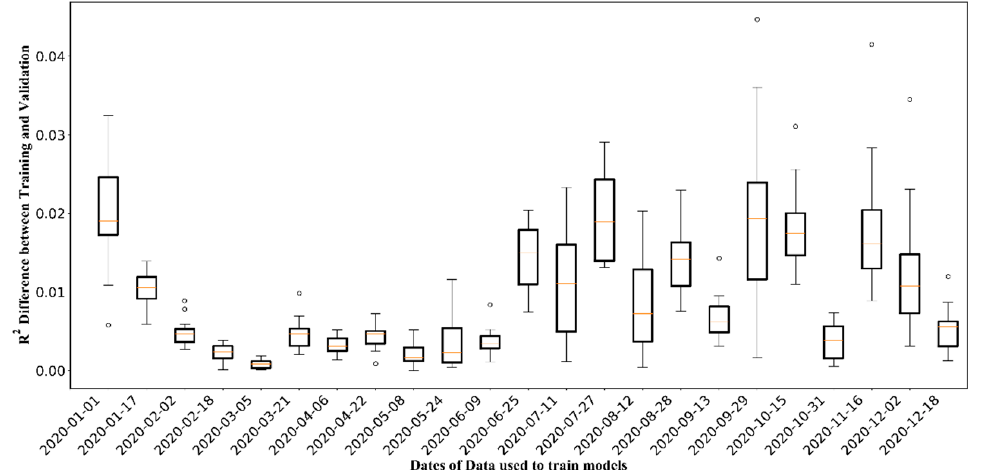
Figure 8. The boxplots of R 2 difference from different NN models with the numbers of layers changing from 1 to 4 and the numbers of neurons of the hidden layers changing from 8 to 64 (the absolute value of the training R 2 minus the validation R 2 ). Each boxplot contains the R 2 difference specific to one date.